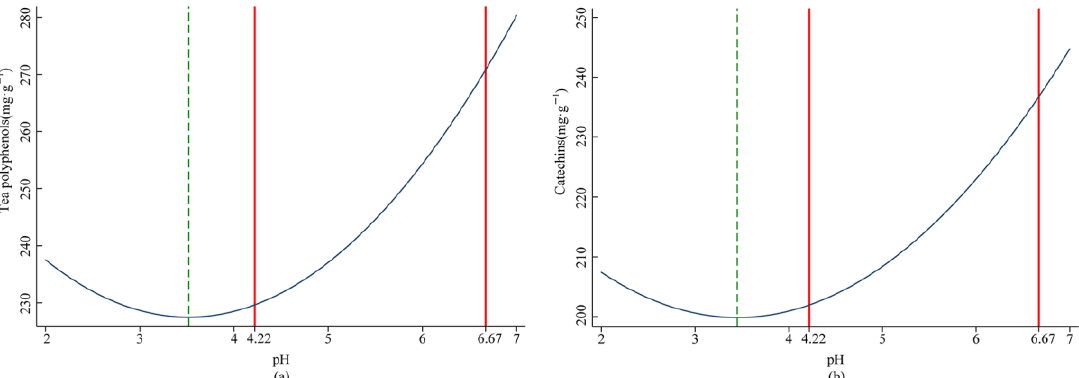
Figure 4. Quantitative relationship between the soil pH and tea polyphenols and catechins. ( a ) Quantitative relationship between the soil pH and tea polyphenols. ( b ) Quantitative relationship between the soil pH and catechins.